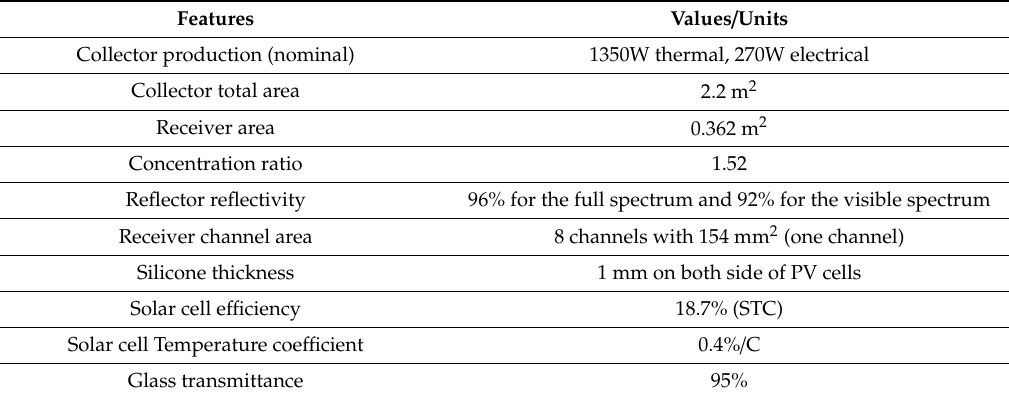
Table 2. The features of the